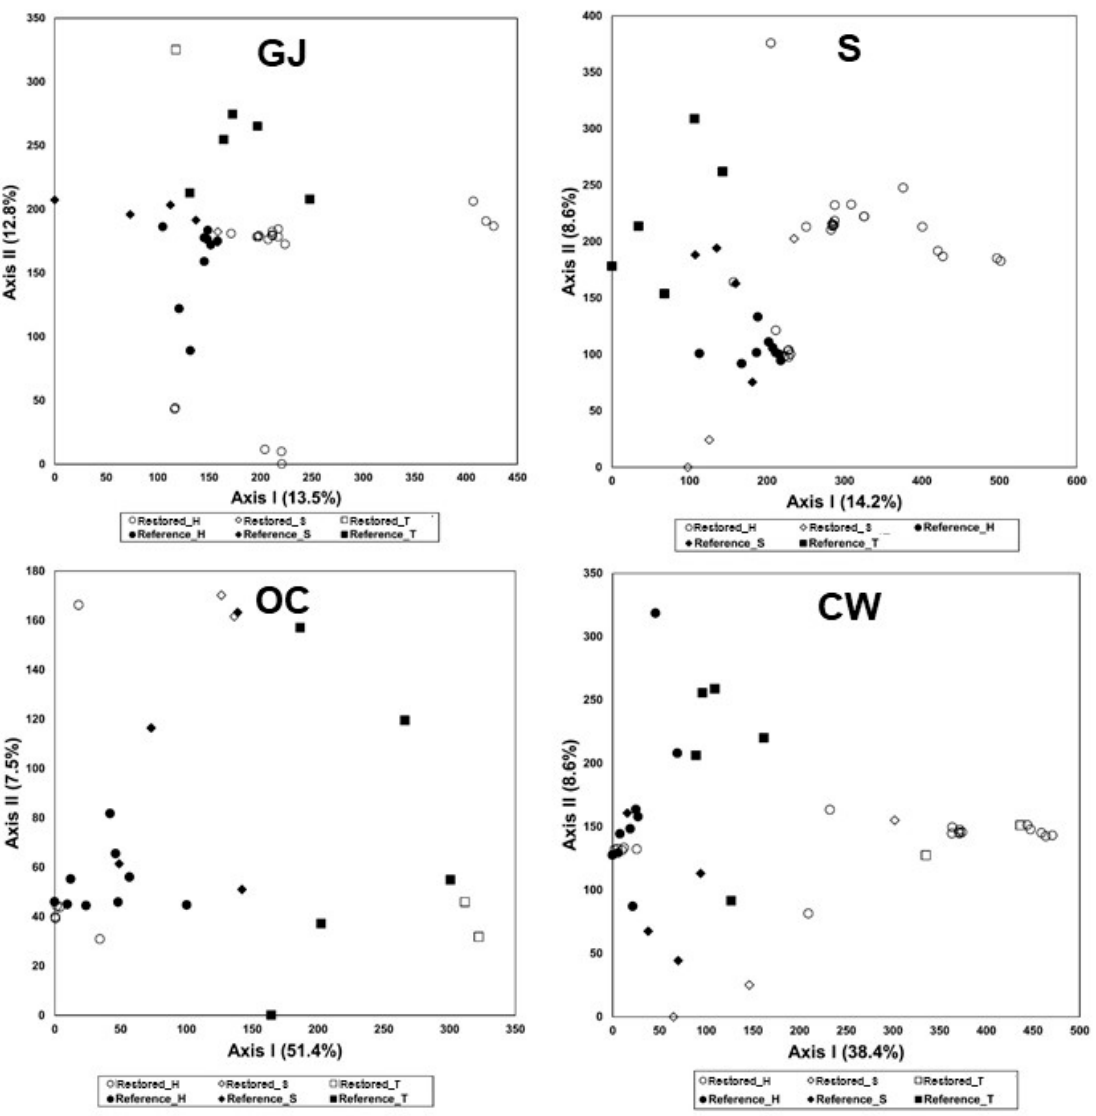
Figure 4. DCA ordination of the stands based on the vegetation data collected from the restored and natural reference rivers. Abbreviated river name is the same as in Figure 3. T: tree dominated vegetation zone, S: shrub dominated vegetation zone, H: herbaceous plant dominated vegetation zone.